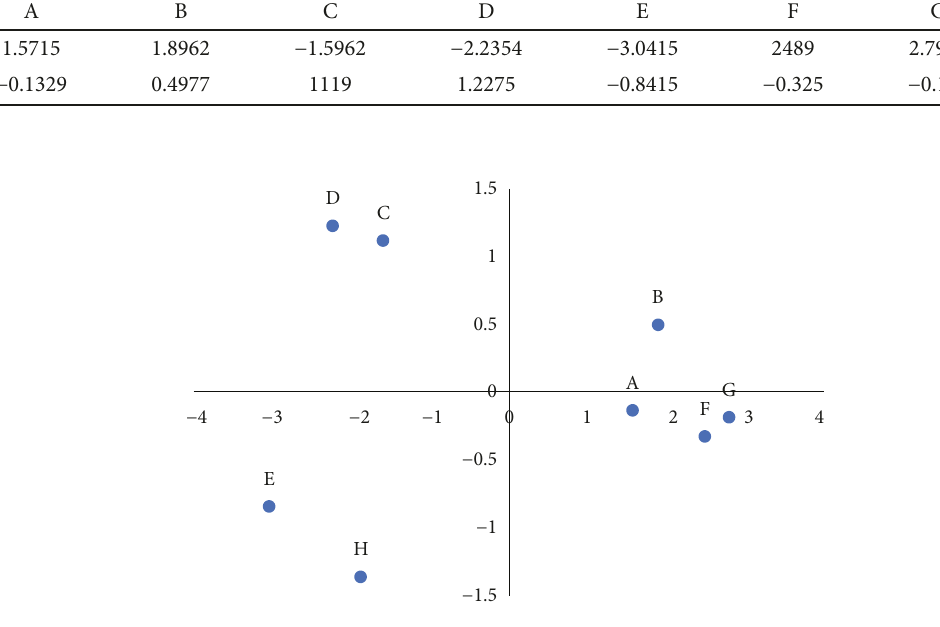
Figure 5: Principal component graph.